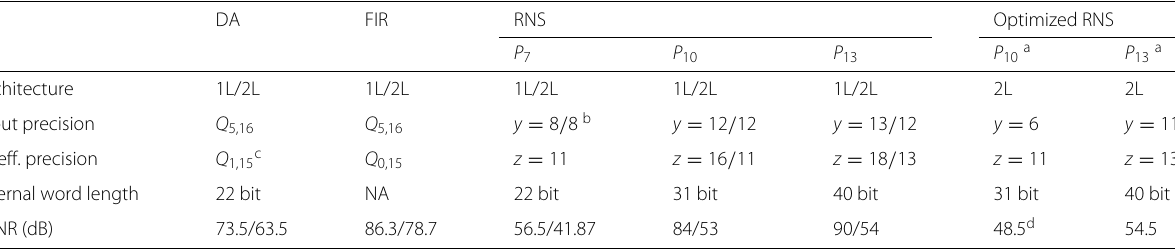
Table 7 The PSNR values of one- and two-level of different DWT implementations